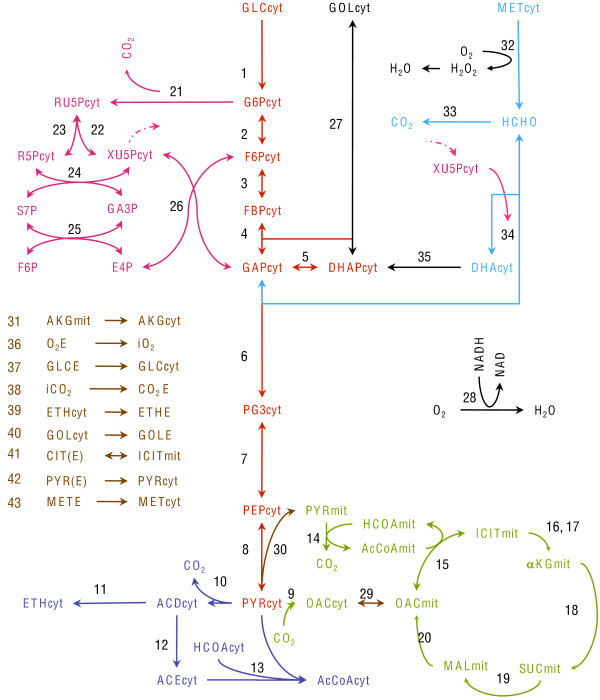
Metabolic network of P. pastoris. Simplified representation of central carbon metabolism of the yeast during growth on glucose, glycerol and methanol. A supplementary reaction represents biomass formation from selected metabolites (see Additional File 1).